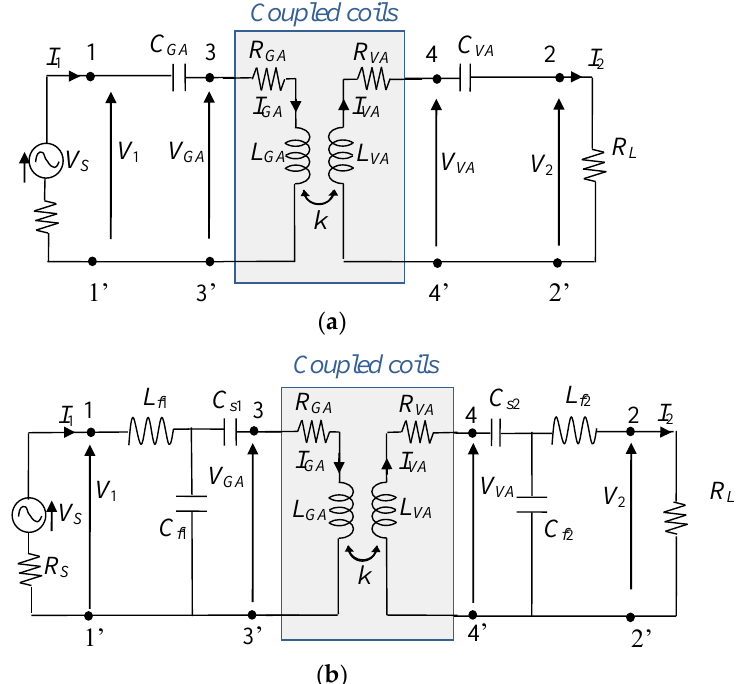
Figure 2. Equivalent simplified circuit of a wireless power transfer (WPT) system with series-series (SS) ( a ) and LCC ( b ) compensation topologies.